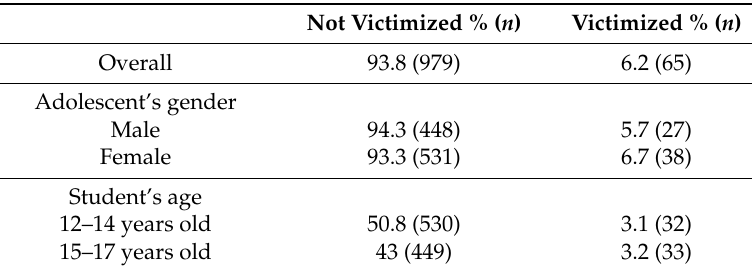
Table 1. Characteristics of the participants by victimization status.